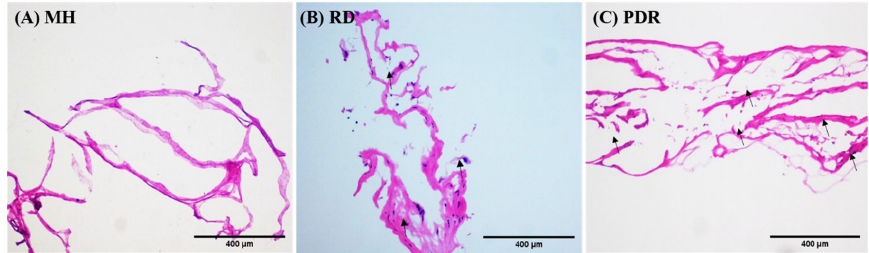
Figure 1. H&E staining of epiretinal membrane ( A ) macular hole, ( B ) retinal detachment, ( C ) proliferative diabetic retinopathy. Photomicrographs in all except macular hole show the presence of spindle shaped cells (black pointed arrows) and the adjacent fibro-collagenous tissue. (H&E; scale bar= 400 μ m).